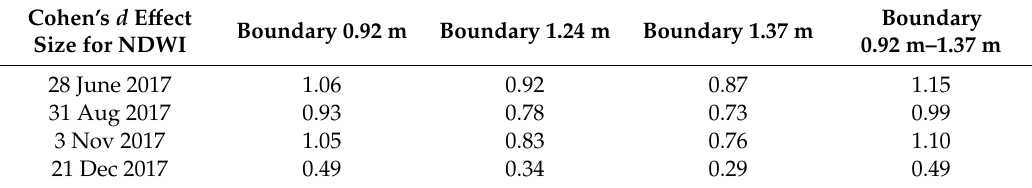
Table 6. Cohen’s d e ff ect size for the di ff erence between average NDWI computed below and above a specific elevation. The elevation separates the persistence and regenerative